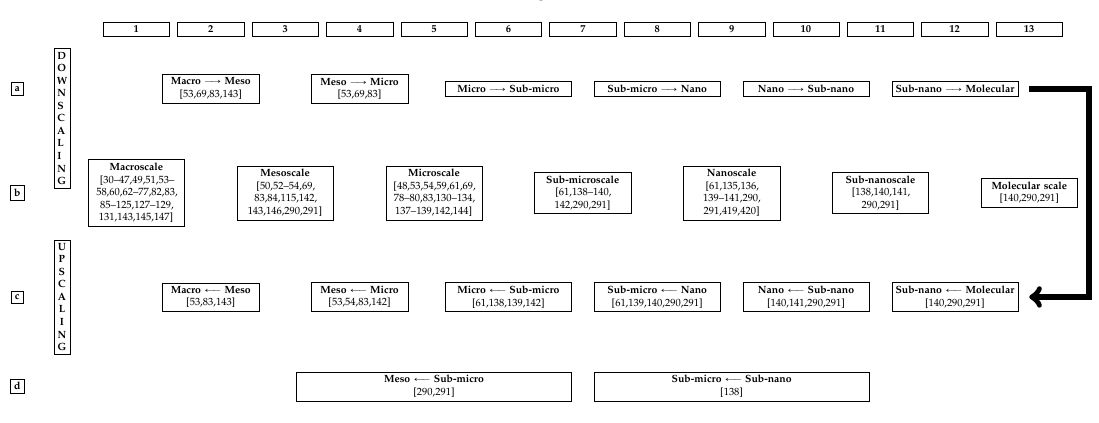
Table 3. Bone multiscale modelling [30–80,82–125,127–147,290,419,420].